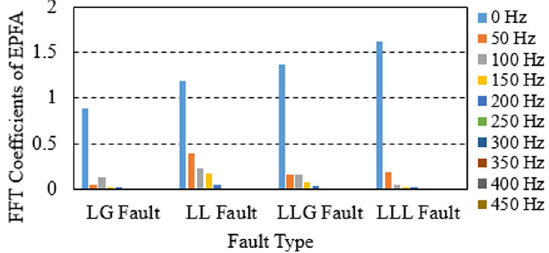
Fig. 5 FFT spectra of EPFA variation with fault conditions of FR = 10 Ω , FIA = 0° in WSCC-9bus system